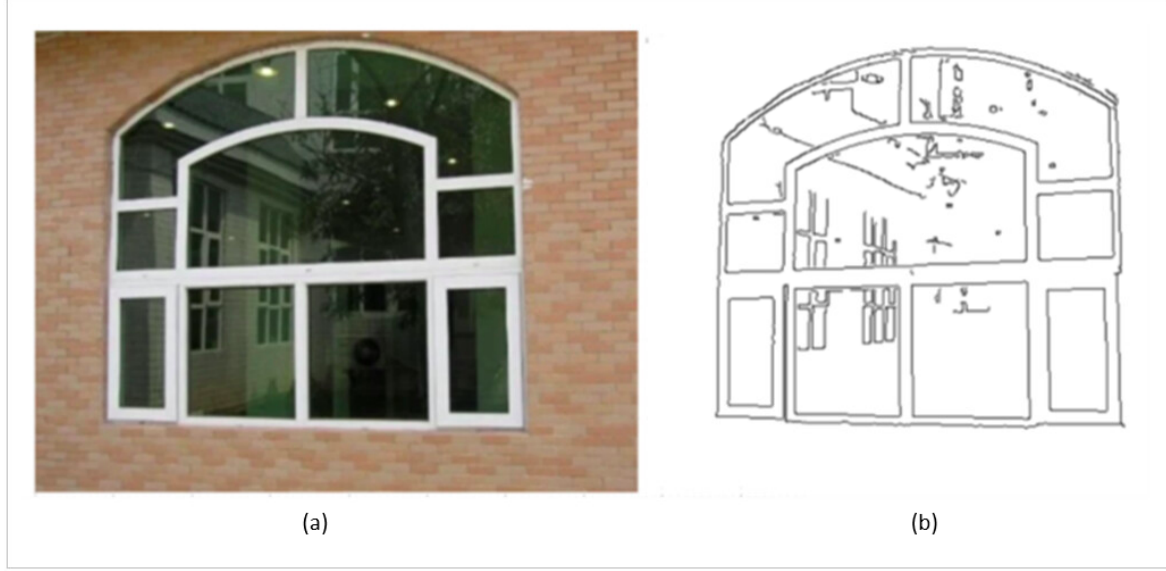
Figure 6. ( a ) A sample window image, ( b ) lines, and edges that make up the window obtained after the detection